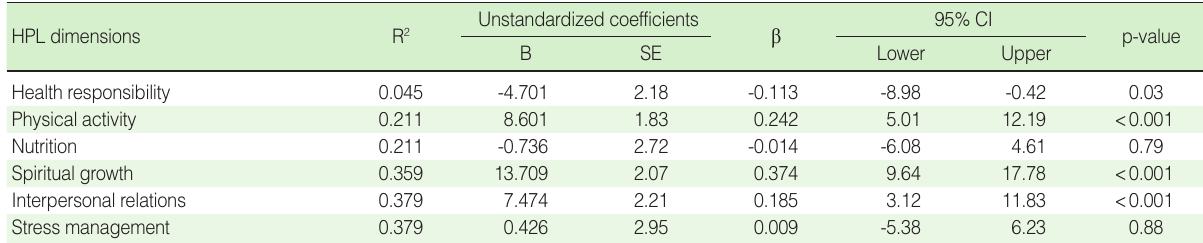
Table 4. Predictive factors of quality of life among the participants as determined by multilevel linear regression analysis HPL dimensions